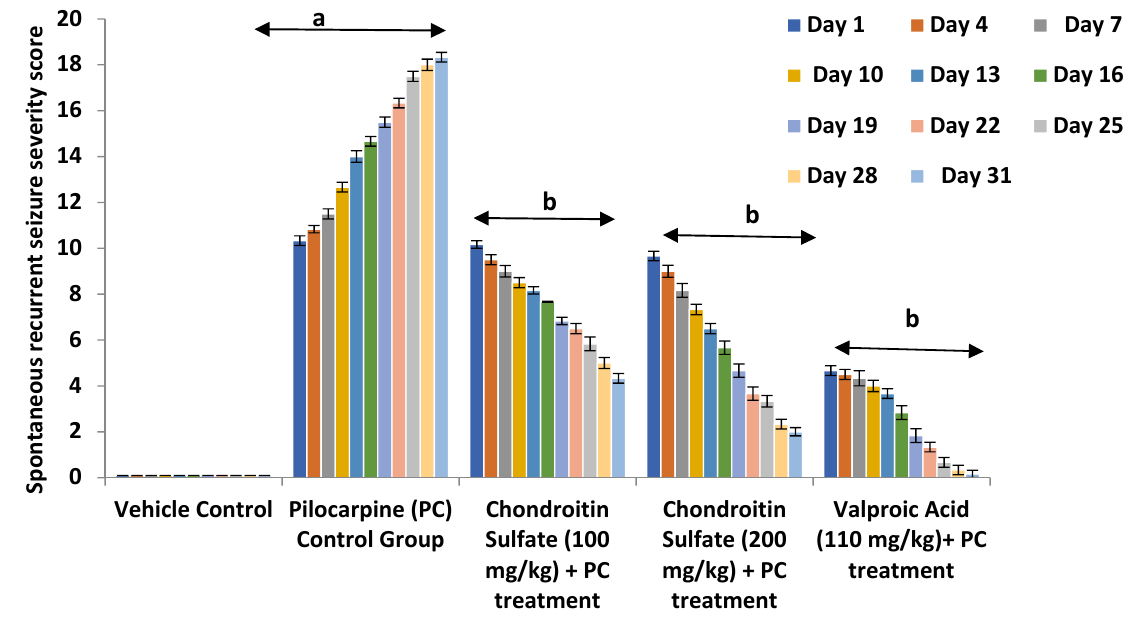
Figure 4. Antiepileptic effect of CS on pilocarpine-induced alteration in spontaneous recurrent severity score mice. Values are expressed as mean ± SEM; a p < 0.01 vs. vehicle control; b p < 0.05 vs. PC control.